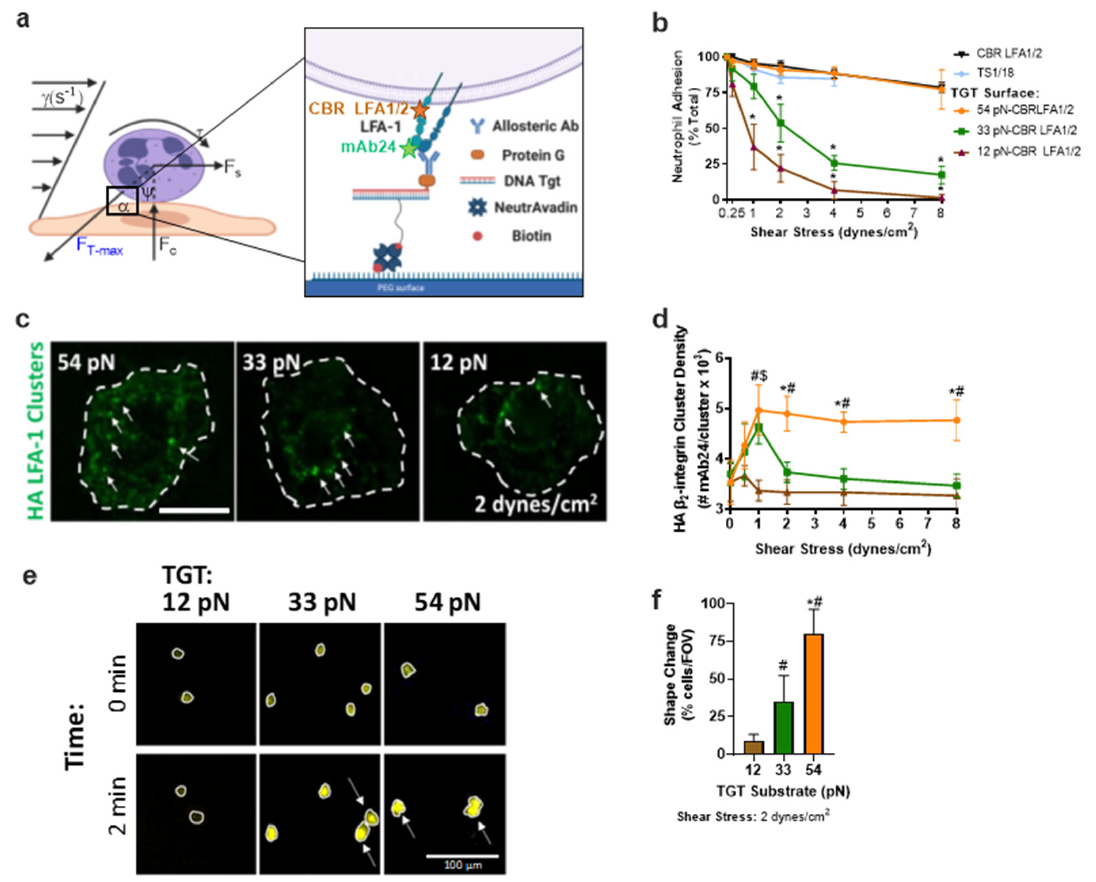
Figure 1. Neutrophils’ adhesion strengthening depends upon the level of bond tension acting on HA β 2 -integrin. ( a ) Schematic of neutrophils sheared in microfluidic channels bound to the glass coverslip via allosteric antibody, CBR LFA1/2 (binding epitope shown in orange) linked to one side of a TGT that is annealed to the substrate on glass coverslips. High-affinity β 2 -integrin was reported on using mAb24 (binding epitope shown by green star) ( b ) Neutrophils binding to each TGT bearing CBR LFA1/2 substrate quantified as the percentage of cells that remained bound after incrementally increasing shear stress, as defined on the x-axis. Arrested neutrophil percent is reported as mean +/- SEM over 5 fields of view with >10 cells per experiment ( n = 3, * compared to CBR LFA1/2, p < 0.01). ( c ) AF488 mAb24 clusters (green) of bound neutrophils sheared over CBR LFA1/2:TGT substrate at (1 dynes/cm 2 ) measured via TIRF; scale bar depicts 5 µ m. ( d ) HA β 2 -integrin cluster density measured via TIRF. Graphs plot HA β 2 -integrin clustering mean +/- SEM for 5 fields of view for each experiment; scale bar shows 10 µ m ( n = 3, * 54pN and 33pN, # 54pN and 12pN, $ 33pN and 12pN, p < 0.01). ( e ) Neutrophils with Ca 2+ reporter Rhod-2 sheared over TGT/HA-inducing β 2 -integrin substrate for 2 min at 2 dynes/cm 2 . White circles show area and arrows identify cells that have undergone shape change compared to time 0; scale bar shows 100 µ m. ( f ) Quantification of the percentage of neutrophils that change shape after shearing for 2 min over TGT/HA-inducing β 2 -integrin substrate. Graphs plot percent shape change mean +/- SEM for 5 fields of view for each experiment ( n = 3, * 54pN and 33pN, # 54pN/33pN and 12pN, p < 0.01, n.s.: not